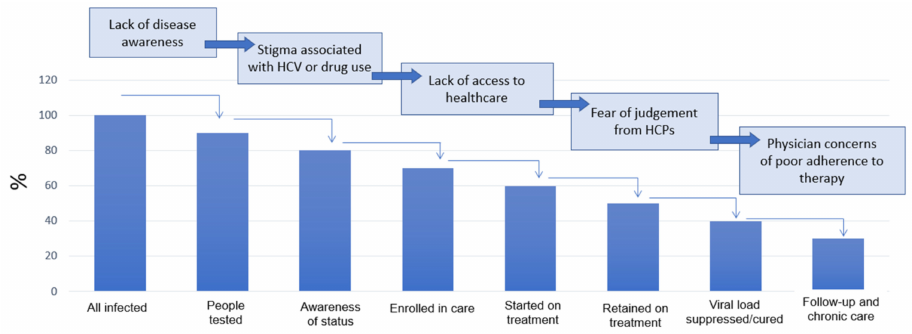
Figure 6. WHO treatment cascade [1]. HCPs—healthcare